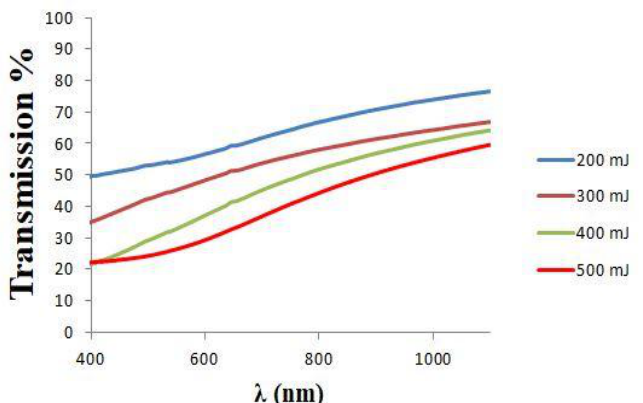
Fig.4: Transmittance of PbS nanostructure deposited at different laser energies as a function of wavelength.